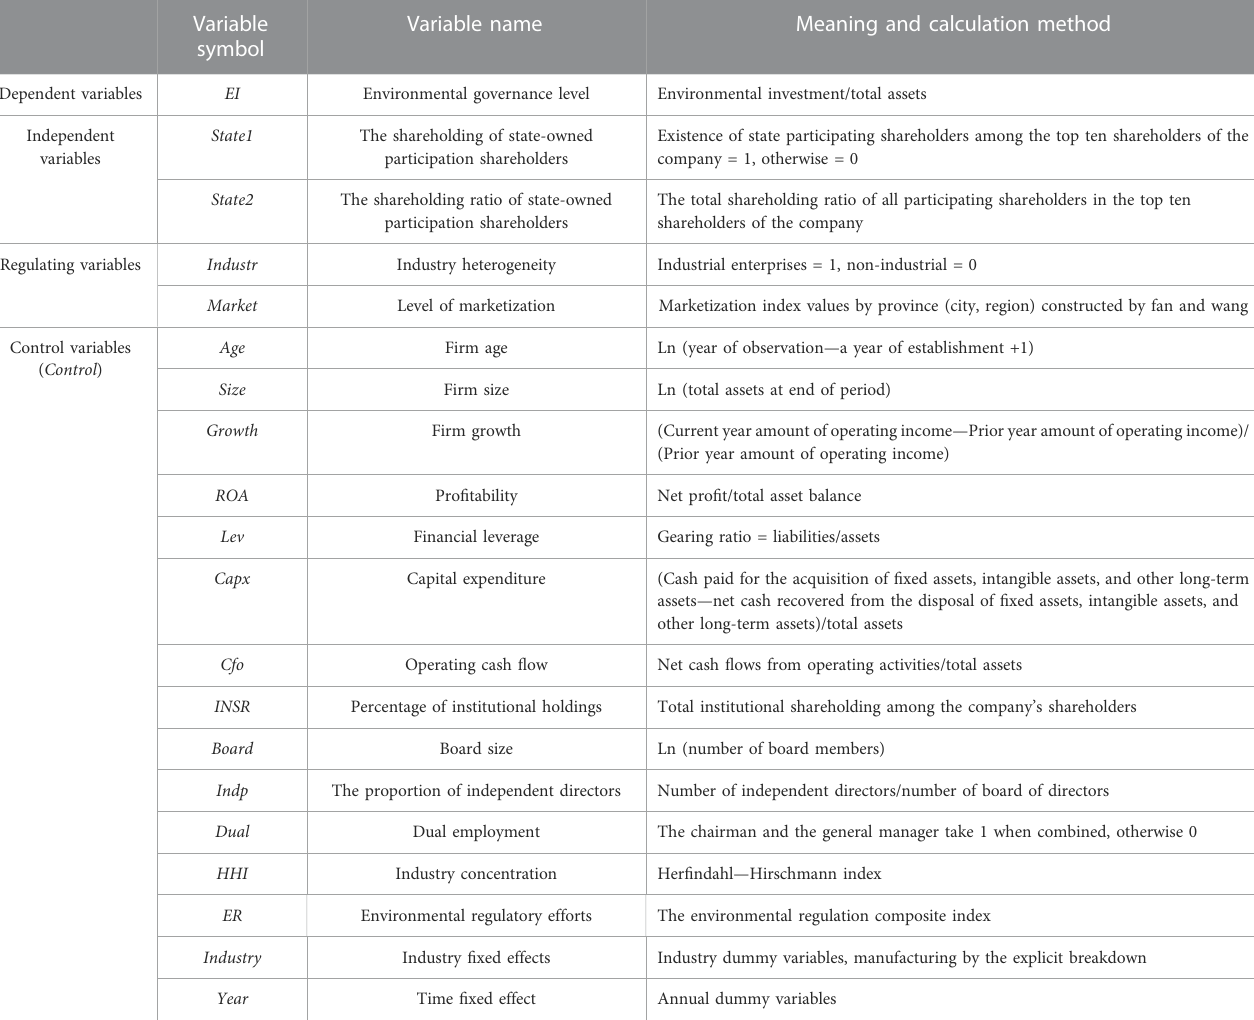
TABLE 1 Meaning and description of